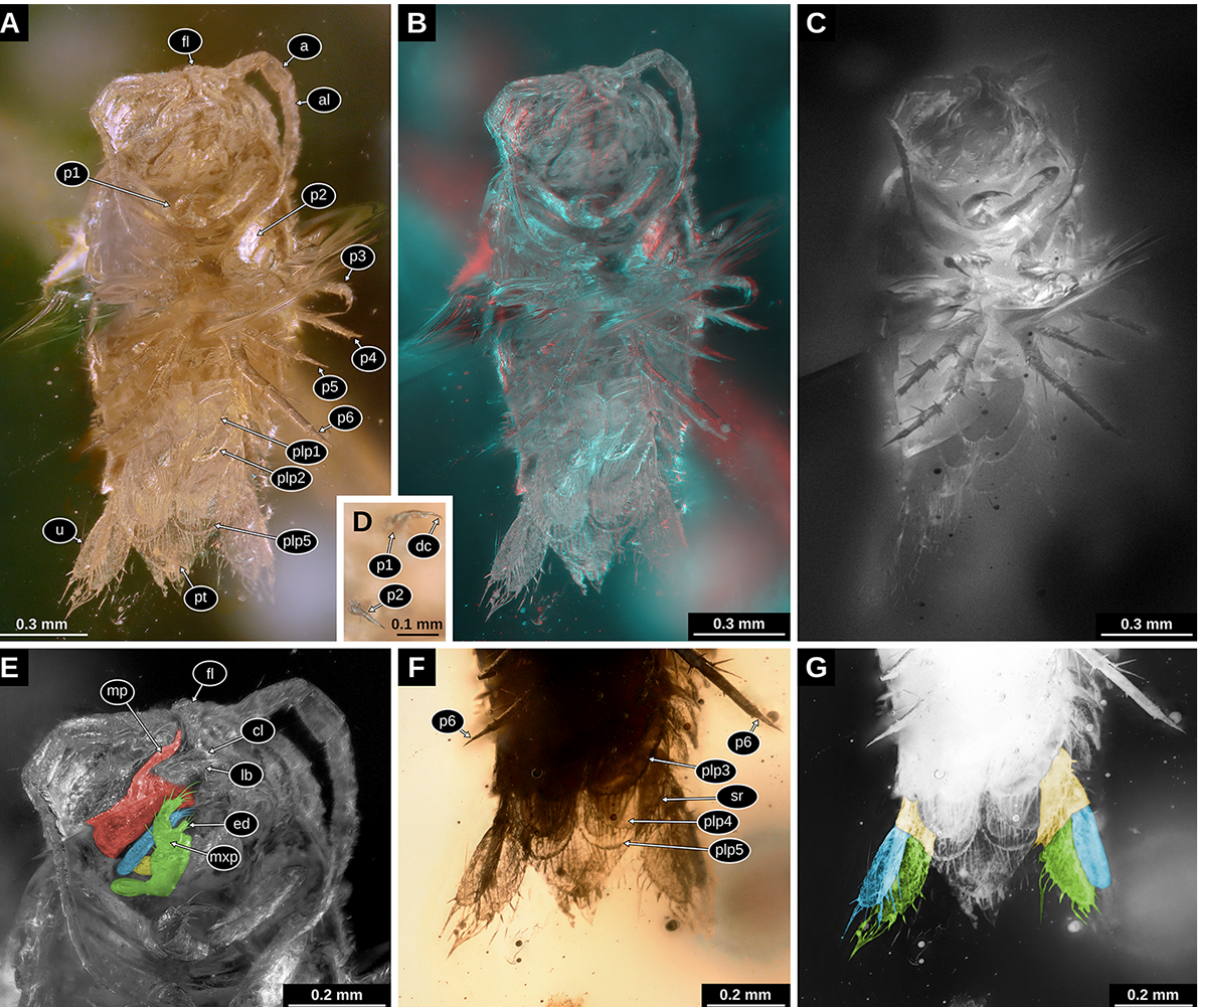
Figure 3. Paratype of Electrolana madelineae sp. nov. (NHMW 2017/0052/0002). A : Habitus in ventral view, white light microscopy, 300x (VHX); B : habitus in ventral view, red-cyan stereo anaglyph, white light microscopy, 200x; C : habitus in ventral view, epifluorescence microscopy, 4x (BZ); D : distal region of trunk appendages 1 and 2 in ventral view, right body side, white light microscopy, 300x (VHX); E : head in ventral view, white light microscopy, desaturated with colour markings, red mandible, blue maxillula, yellow maxilla, green maxilliped, 300x (VHX); F : pleon region in ventral view, white light microscopy, 300x (VHX); G : pleon region in ventral view, white light microscopy, desaturated and inverted, with color markings, yellow basipod, green endopod, blue exopod, 300x (VHX). a, antenna; al, antennula; cl, clypeus; dc, dorsal claw; ed, endite of the maxilliped; fl, frontal lamina; lb, labrum; mp, mandibular palp; mxp, maxilliped; p1–6, trunk appendages 1–6; plp1–5, pleopod 1–5; pt, pleotelson; sr, serration pattern; u,